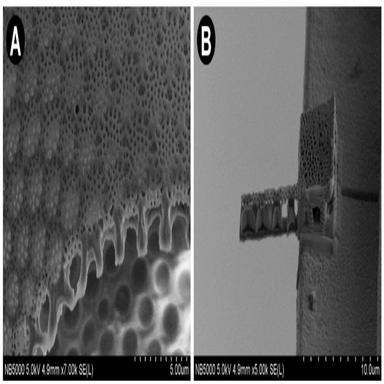
SEM images of the Coscinodiscus sp. frustule prepared using dual beam microscope (FIB-SEM): (A) cross-section, (B) lamella.